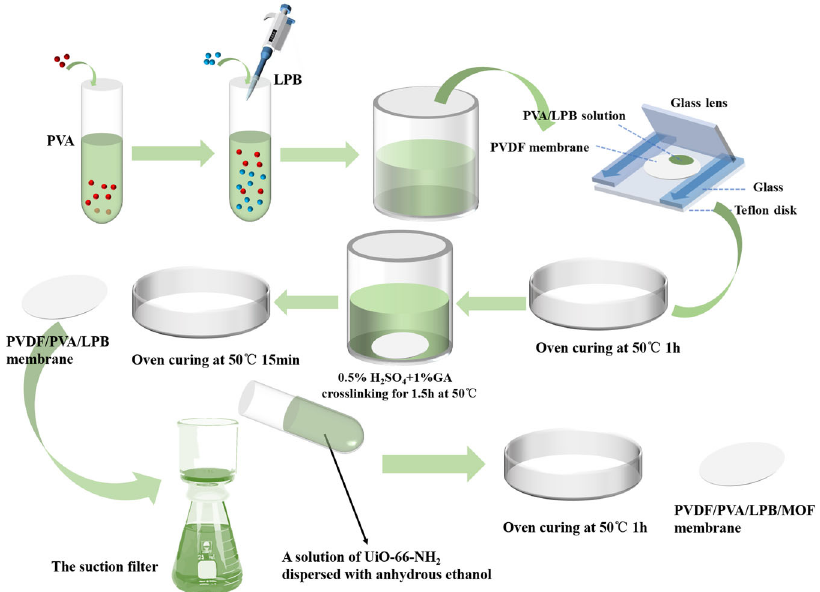
Fig. 8 Synthetic strategy diagram of PVDF/PVA/LPB/UiO-66-NH 2 hybrid separation